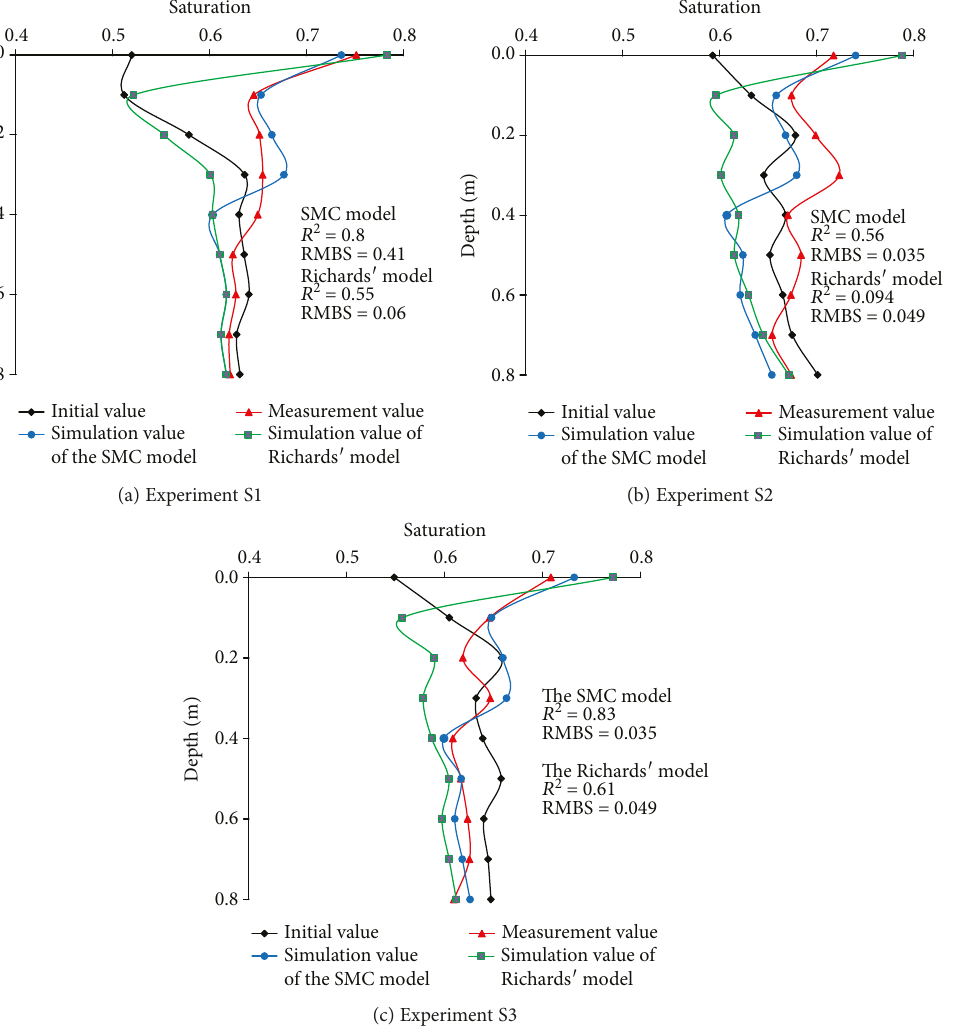
Figure 9: Comparison of saturation between measured values and simulated values of each